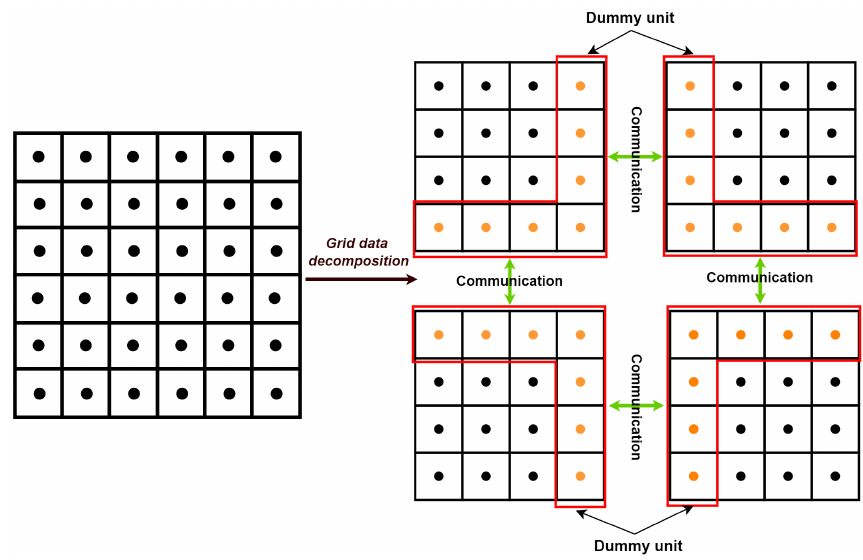
Figure 2. Grid data decomposition. The left figure shows the original grid model. The right side indicates the four sub-grids after data decomposition. Dummy cells are generated at the boundary of each subgrid. It is only used for data communication during grid computation of different processes.